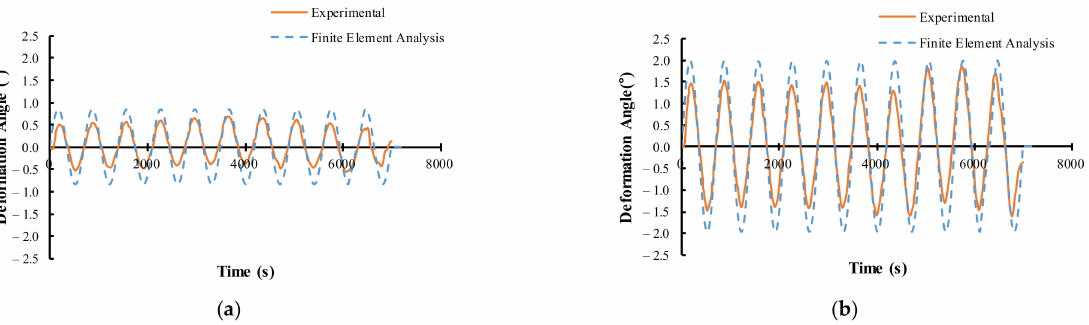
Figure 11. Validation of the deformation angles of the large-scale press-to-connect piping system: ( a ) lower elbow; ( b ) upper